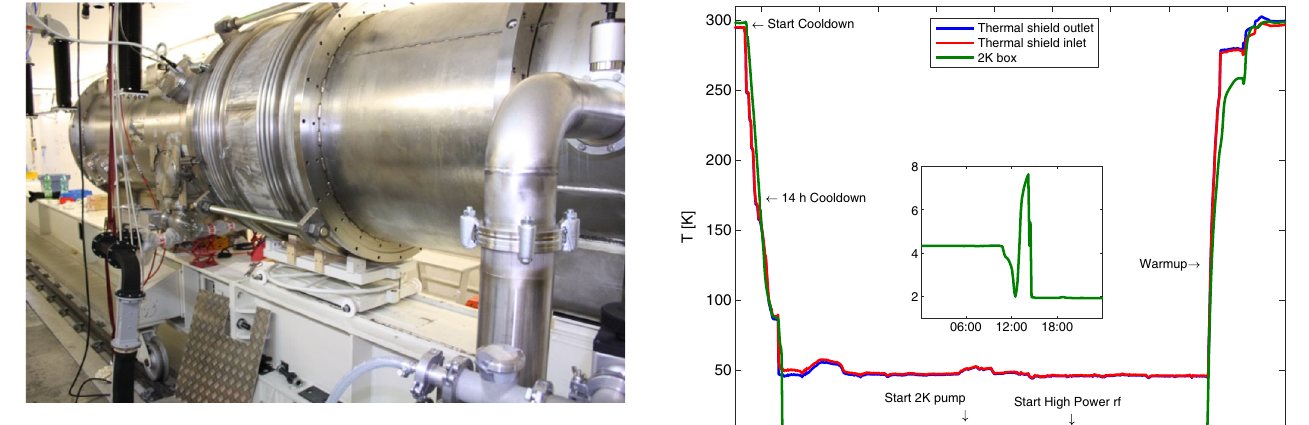
FIG. 4. The cryostat adapter during its connection to the XATB1 cryogenic feedbox.